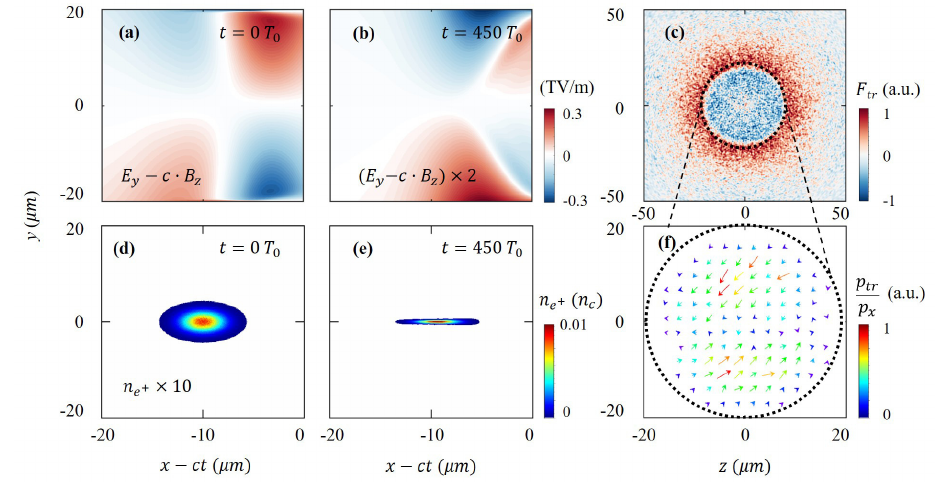
Figure 3. Distribution of the transverse electromagnetic field E y − c · B z in the x-y plane at the moment of ( a ) t = 0 T 0 and ( b ) t = 450 T 0 . ( c ) Distribution of transverse forces exerted on the positrons in the y-z plane at t = 450 T 0 . The dashed circle indicates the position of the hollow electron bunch at r = 20 µ m. Positron density distribution at ( d ) t = 0 T 0 and ( e ) t = 450 T 0 . ( f ) Transverse momentum vector map (normalized with the longitudinal momentum p x ) of positrons within the dashed circle in ( f ).